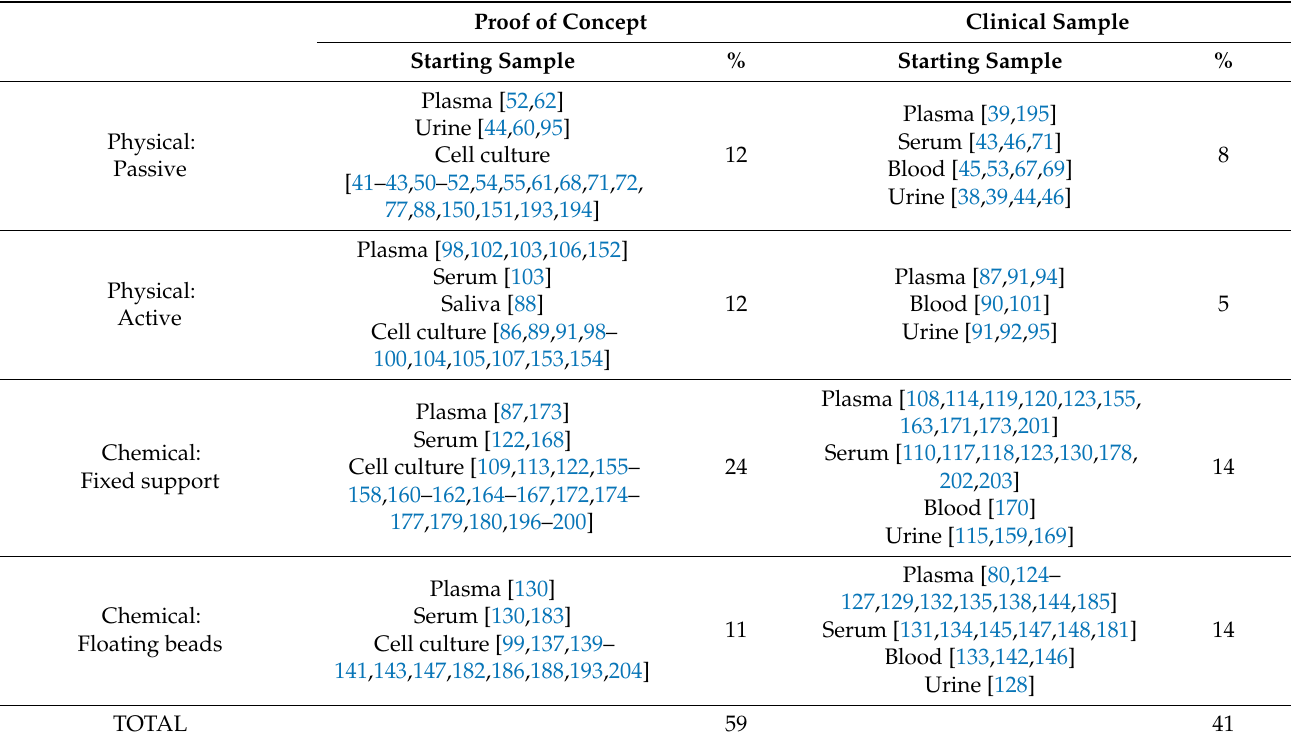
Table 4. Summary of articles published during the years 2000–2022 dealing with EV isolation from microfluidic devices processing samples for research purposes or clinical trials, according to techniques classified in Table